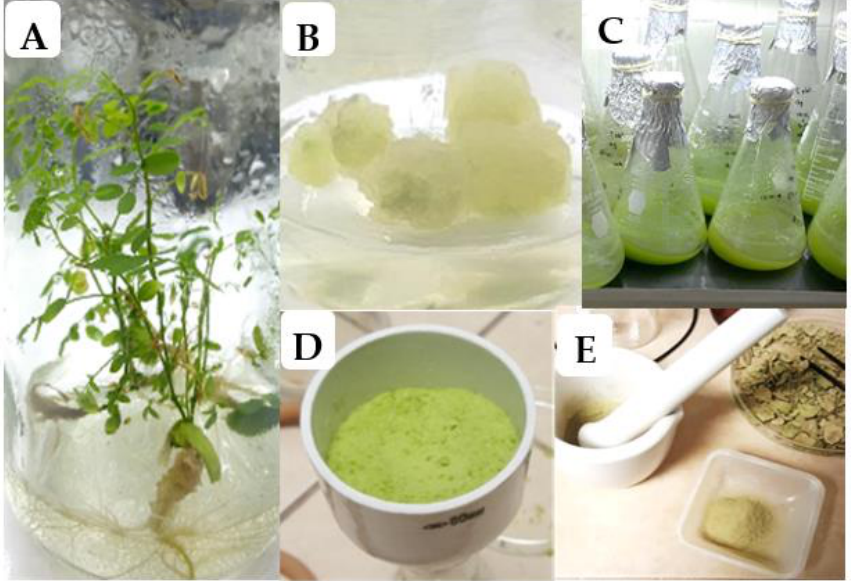
Figure 1. In vitro cultures of Eysenhardtia platycarpa . ( A ) Plantlets grown in MS culture medium without plant growth regulators; ( B ) callus production at 15 days of culture; ( C ) cell suspension cultures with 2 mg/L NAA and 0.5 mg/L KIN; ( D ) fresh biomass harvested after 12 days of culture; ( E ) dried biomass used for obtaining extracts. Table 1. Percentage of internodal explants of Eysenhardtia platycarpa inducing callus in Murashigue and Skoog (MS) culture medium after 30 days of culture. PGRs (mg/L) Callus Induction (%)